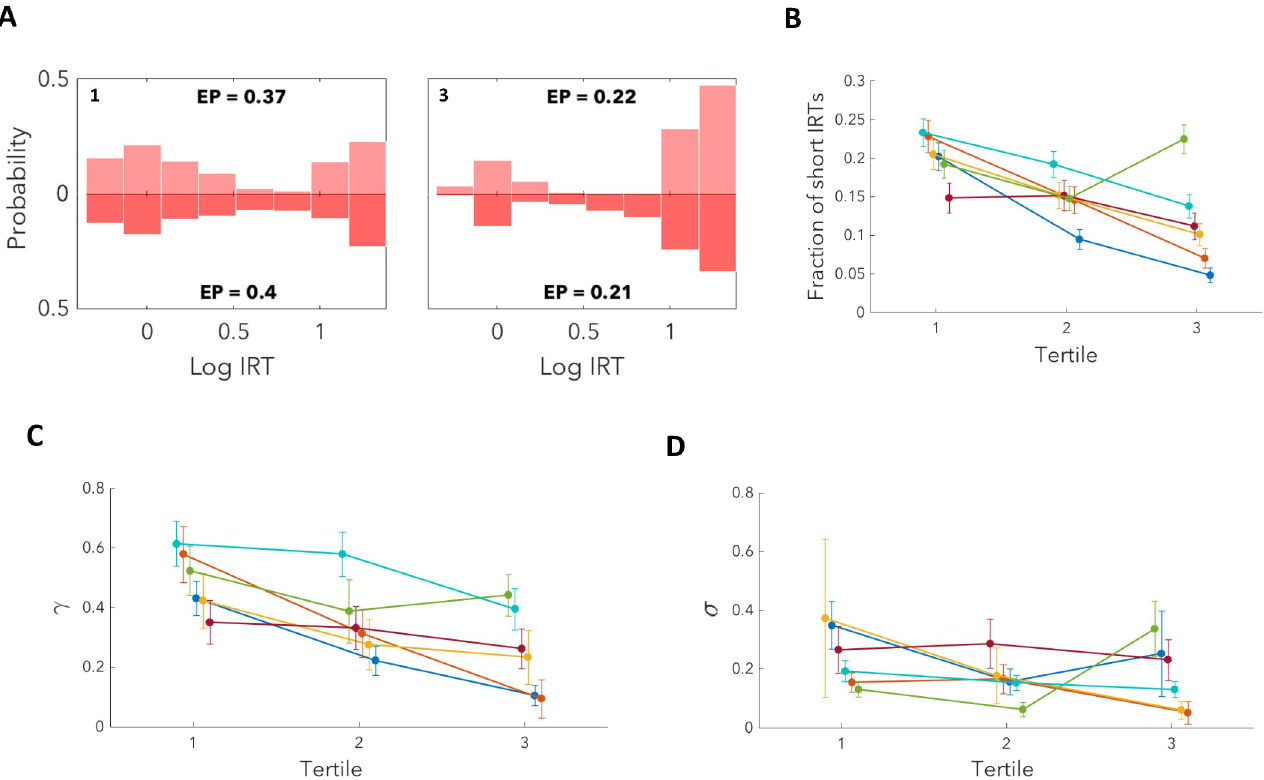
Fig 7. Mistaken inference becomes less likely with experience, as subjects learn to use past evidence. ( A ) Upper: simulated; lower: real. We divided the data into three tertiles, fit parameters independently for each tertile and simulated responses. We illustrate the first and last tertile in which subject 1 both lowers its EP and also decreases the probability of short IRTs in cases when it does respond. ( B ) By plotting the fraction of short IRTs in each tertile we find a significant decrease from first to last tertile for 4/6 subjects (permutation test; h 11 ) indicating that these subjects improve in their ability to identify the trail trial. The remaining two subjects show no significant change. ( C ) By calculating γ for each tertile we find that 4/6 subjects show a significant decrease in the MLE estimate of γ from the first to last tertiles, with the remaining two subjects showing no significant change (permutation test; h 12 ). Although significance was tested using a permutation test, we illustrate errorbars using the mean square error in the MLE of the parameters. The decrease in γ over time for the majority of subjects suggests a process by which subjects learn to use past evidence. ( D ) There is no significant change in the MLE of σ for 3/6 subjects with two subjects showing a significant decrease and one a significant increase (permutation test; h 13 ). We therefore do not find strong evidence to suggest that improvements in performance in the majority of subjects was due to a more accurate association of frequency and price with the trial